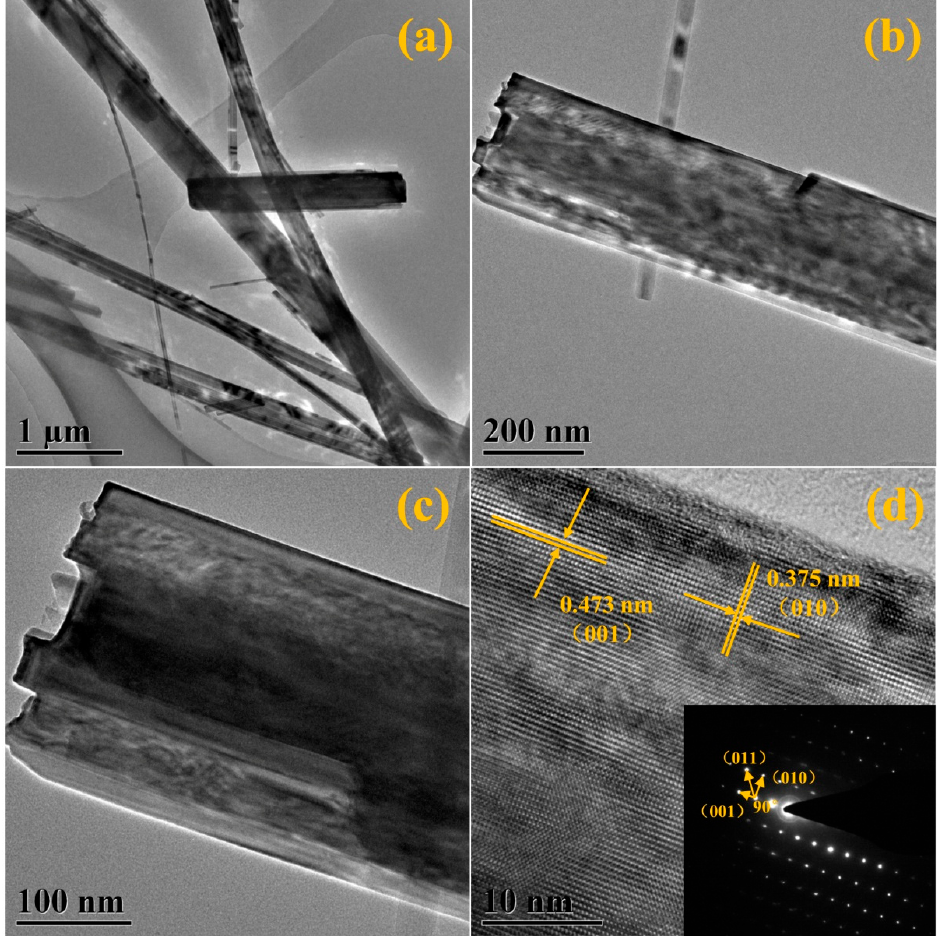
Figure 15. Transmission electron microscopy (TEM) characterization of NaV 2 O 5 mesocrystals synthesized under the optimal conditions. ( a , b ) TEM images of NaV 2 O 5 mesocrystals; ( c ) partial magnified image of the NaV 2 O 5 mesocrystals; ( d ) high-resolution transmission electron microscope (HRTEM) image of NaV 2 O 5 (inset is the corresponding selected area electron diffraction (SAED) pattern).